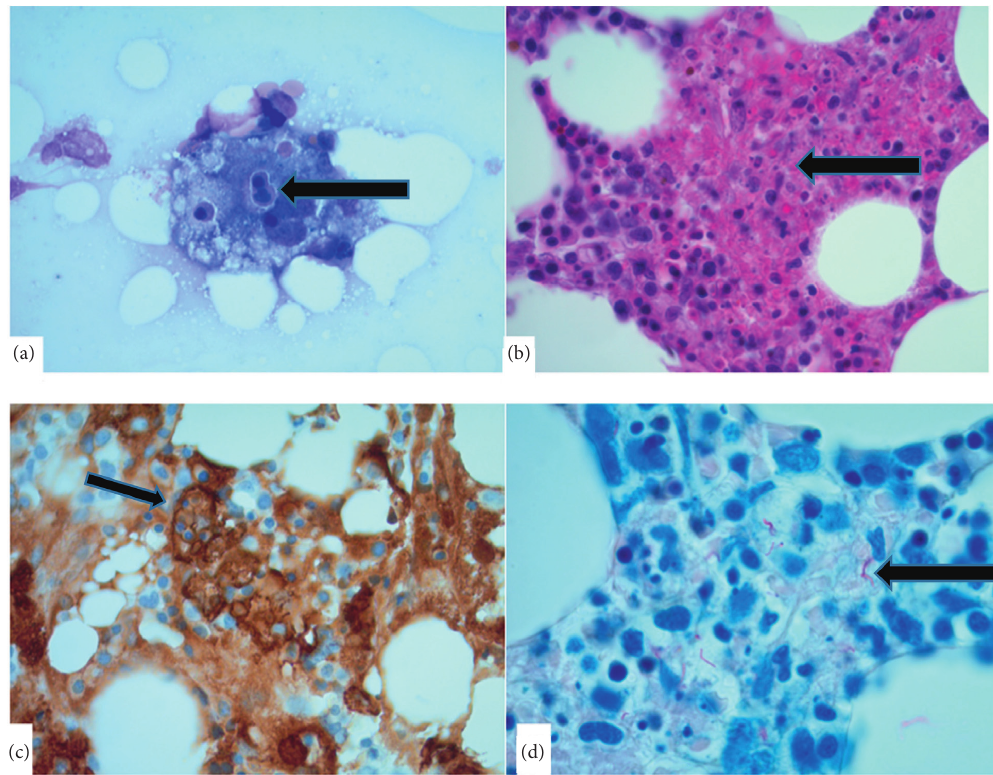
Figure 2: 40x magnification. (a) Bone marrow aspirate smear showing histiocyte with hemophagocytosis. (b) Bone marrow biopsy H&E stain showing foci of necrosis by normal bone marrow. (c) CD163 stain showing histiocyte engulfing other hematopoietic cell (rosette appearance). (d) FITE stain showing acid-fast